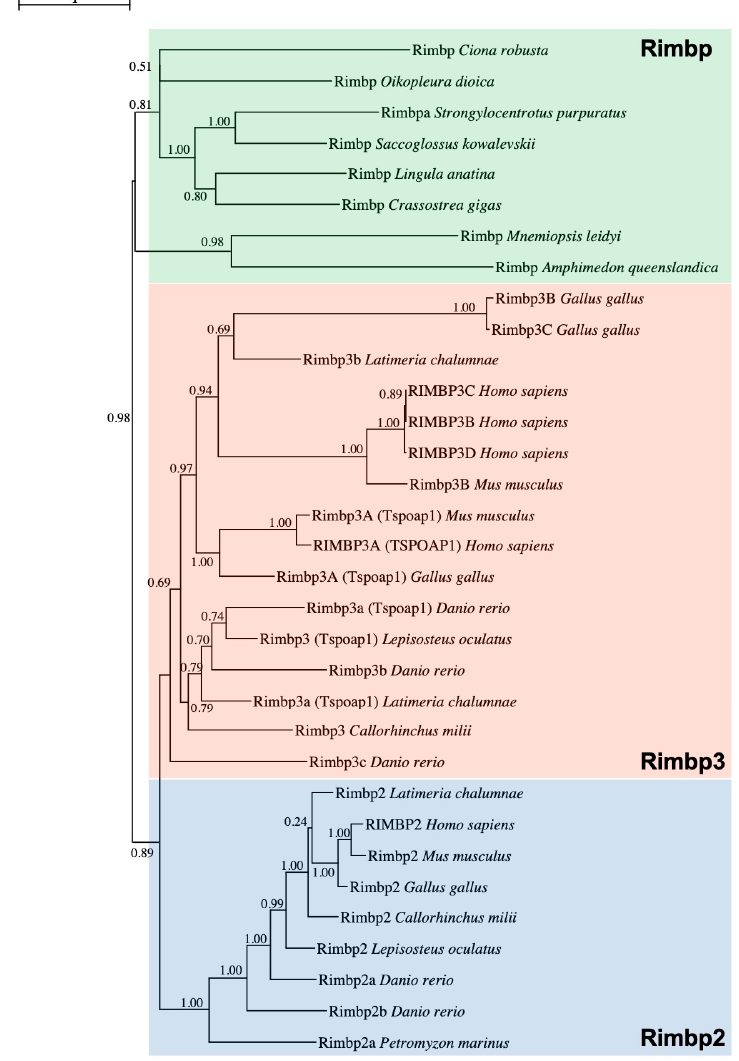
Figure 1. The evolutionary history of Rimbp proteins. Maximum Likelihood (ML) phylogenetic tree supporting the orthology among Rimbp of invertebrates (green box) and both Rimbp2 (blue box) and Rimbp3 (orange box) of vertebrates, with brackets highlighting the name commonly used for several Rimbp3 . Values at branches represent replicates obtained using the ML estimation method; the whole protein sequence has been used for tree inference.